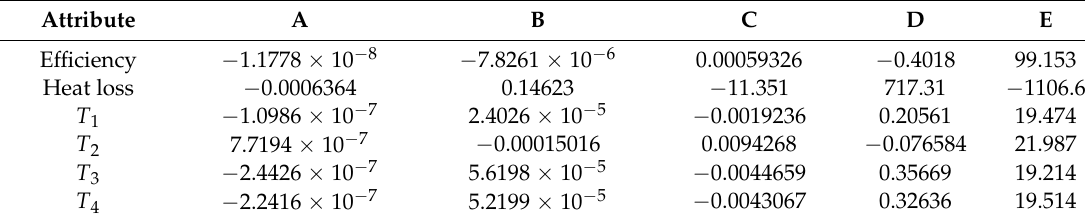
Table 4. Polynomial equations during charge.